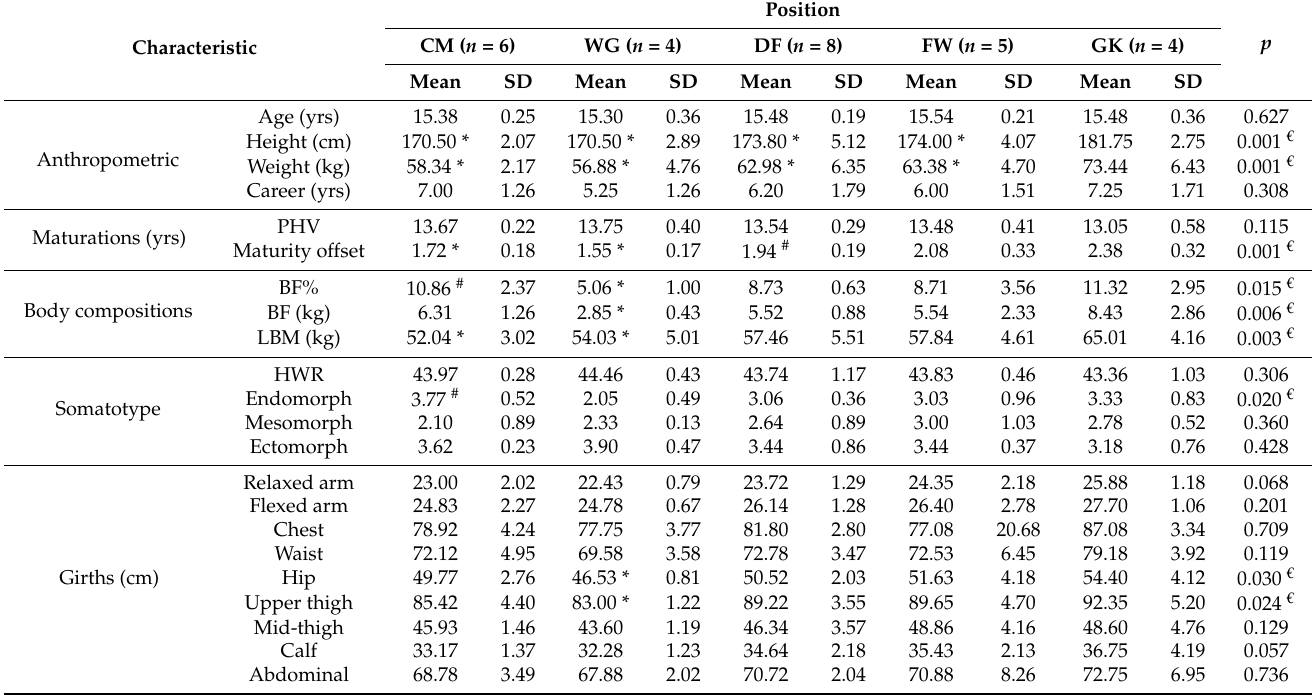
Table 1. Absolute size characteristic, body composition, somatotype and anthropometric of soccer player by playing positions.